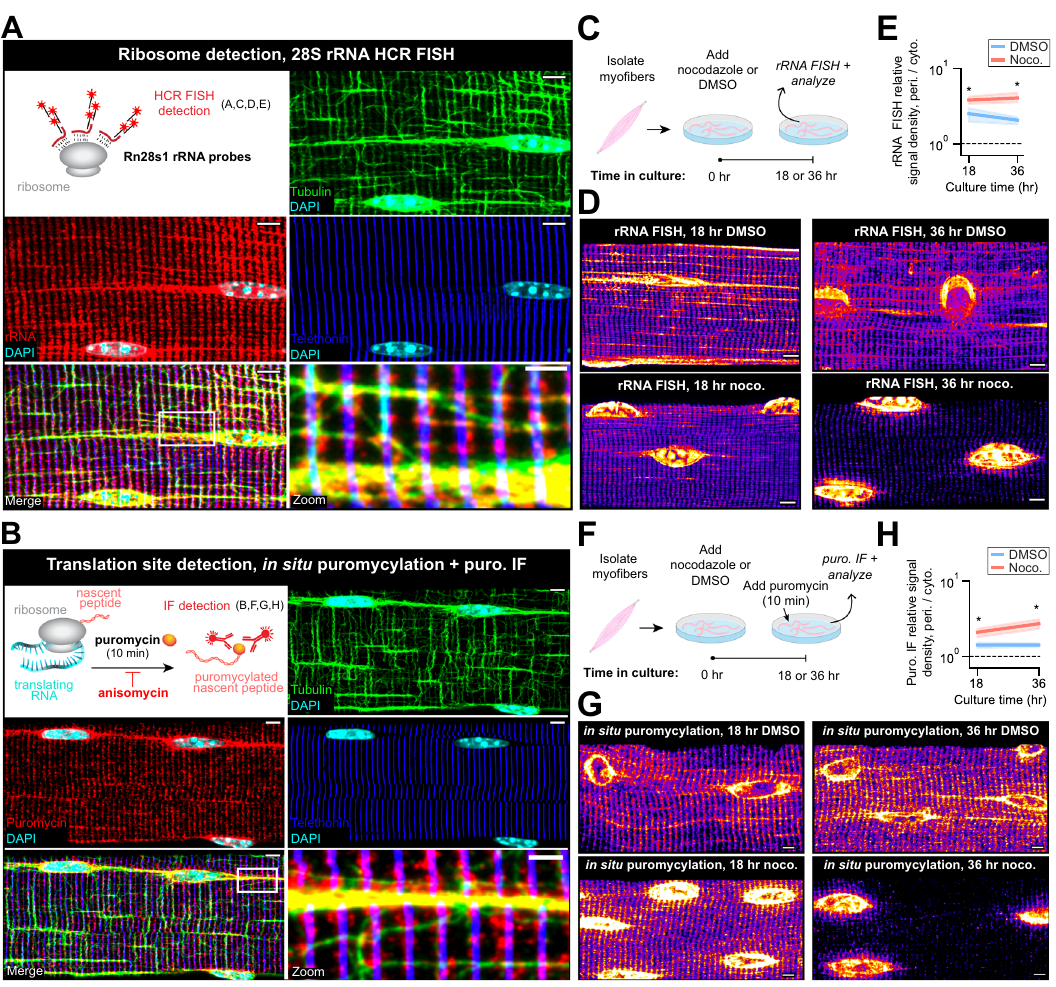
Fig. 6 Nocodazole treatment causes accumulation of ribosomes and nascent protein around myonuclei. A Ribosomes were detected in isolated myo fi bers using HCR FISH for 28S ribosomal RNA. Representative images of IF/FISH co-labeling for tubulin (green) and telethonin (blue) proteins with rRNA (red) in myo fi bers. Scale bars: 5 µ m. B Active translation was detected in isolated myo fi bers using in situ puromycylation. Representative images of puromycin detection (red) with tubulin (green) and telethonin (blue) IF in myo fi bers. Scale bars: 5 µ m. C Live myo fi bers were isolated and cultured with nocodazole or DMSO (control) for 18 or 36 hr. At each time point, rRNA FISH was performed. D Representative images of rRNA FISH signal in myo fi bers from C . Scale bars: 5 µ m. E Perinuclear to cytoplasmic relative rRNA signal density (pixel intensity per µ m 3 ) in myo fi bers from C . Mean ± 95% CI. n = 5 myo fi bers per condition. * p < 0.05, Two-sided Mann – Whitney U test. F Live myo fi bers were isolated and cultured with nocodazole or DMSO (control) for 18 or 36 h. At each time point, in situ puromycylation was performed as described in B . G Representative images of puromycin IF in myo fi bers from F . Scale bars: 5 µ m. H Perinuclear to cytoplasmic relative puromycin signal density in myo fi bers from F . Mean± 95% CI. n = 5 myo fi bers per condition. * p < 0.05, Two-sided Mann – Whitney U